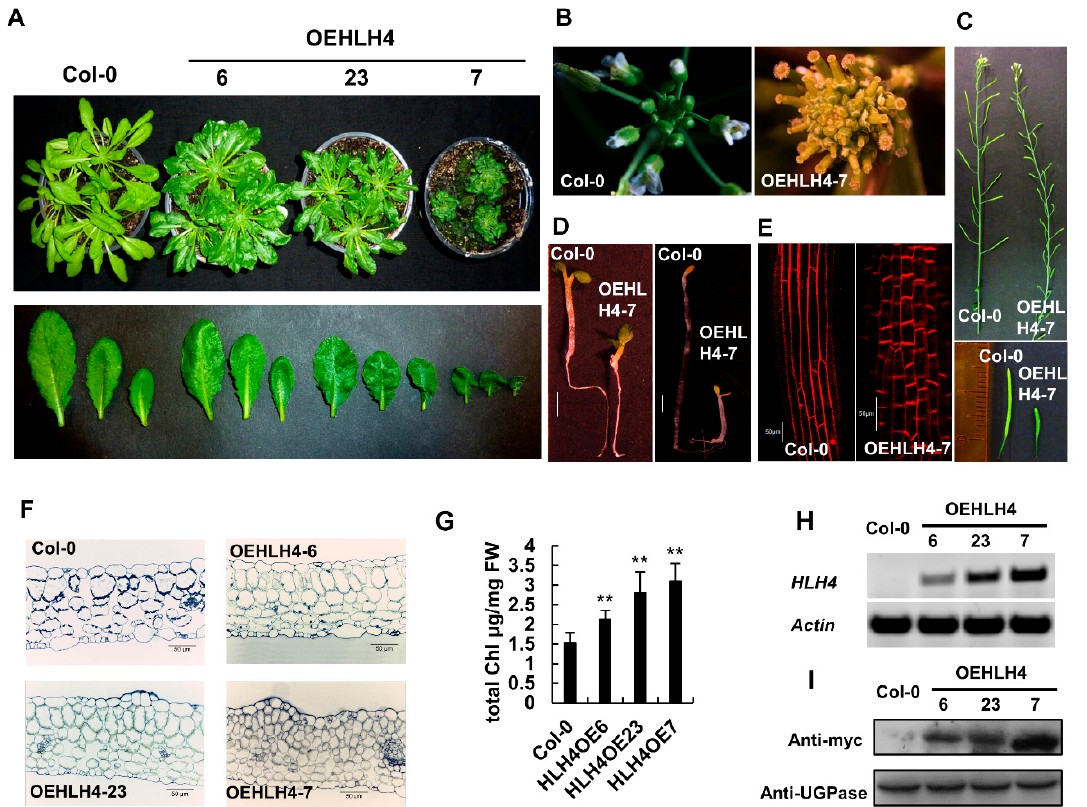
Figure 1. Overexpression of HLH4 causes dwarf and dark green phenotypes. ( A ) Phenotypes of whole plants and leaves of different HLH4 overexpression A. thaliana lines. ( B ) HLH4 overexpression lines showed abnormal flowers at the initial stage of flowering. ( C ) Siliques of HLH4 overexpression lines are shorter than those of wild-type plants. ( D ) Hypocotyls of HLH4 overexpression lines are shorter than wild-type (Col-0) plants grown under light or dark conditions, and cotyledons of HLH4 overexpression lines are unfolded in the dark. Bar = 1 mm. ( E ) Hypocotyl cells of HLH4 overexpression lines are shorter than those of wild-type plants. Seedlings were stained with propid- ium iodide and examined by confocal microscopy. Bar = 50 µ m. ( F ) Leaf cross-sections of wild-type and different HLH4 overexpression lines. Bar = 50 µm. ( G ) Chlorophyll content of wild-type and different HLH4 overexpression lines. Data represent mean ± SD of three biological replicates with three technical replications ( n = 9). Asterisks indicate significant differences (** p < 0.01) . ( H ) Tran- scription levels of HLH4 in leaves of wild-type and different HLH4 overexpression lines. ( I ) protein expression levels of different HLH4 overexpression lines. 3.2. HLH4 is Localized in the Nucleus and Predominantly Expressed in Seedlings and Reproductive Organs The HLH4 gene has a paralog, HLH3 ( At2g18969 ). The HLH4 and HLH3 genes show synteny in the A. thaliana genome, suggesting that these two loci are segmental duplica- tions (Figure 2A). HLH4 and HLH3 encode proteins with 158 and 175 amino acid residues, respectively. Helix structures are predicted in the C-terminal regions of the two proteins (Figure 2B). Amino acids (~17 aa) in front of the helix region of bHLH proteins comprise the basic region determining DNA binding activity. Although sequences of HLH4 and HLH3 are highly conserved, HLH3 was excluded from the bHLH family in early reviews [38–40], and only later identified as a novel atypical bHLH protein [41]. hlh4 and hlh3 single mutants and hlh4hlh3 double knock-out mutants did not show any phenotypic differences compared to wild-type plants under normal conditions (Figure S1). While overexpression of HLH4 causes dwarf and dark green phenotypes, no pheno- typic abnormalities were observed in HLH3 overexpression lines (54 independent trans- genic lines were examined), suggesting divergence of HLH4 and HLH3. The sequence of